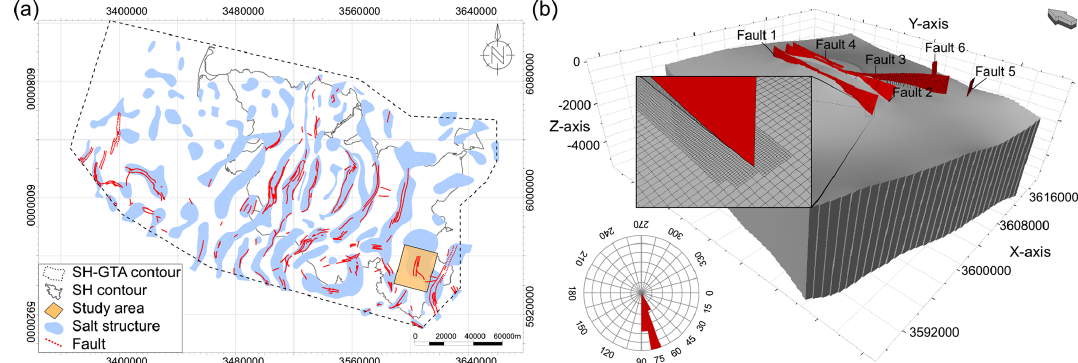
Figure 1. (a) Salt structures, associated faults and the study area within the NGB in Schleswig-Holstein (SH). The dashed outline is the area of Geotectonic Atlas of Northwestern Germany and the German North Sea (GTA) within SH (after Baldschuhn et al., 2001; Hese, 2012); (b) 3-D geological structure model created for the study with six fault systems (average dip angle 61 to 82 ◦